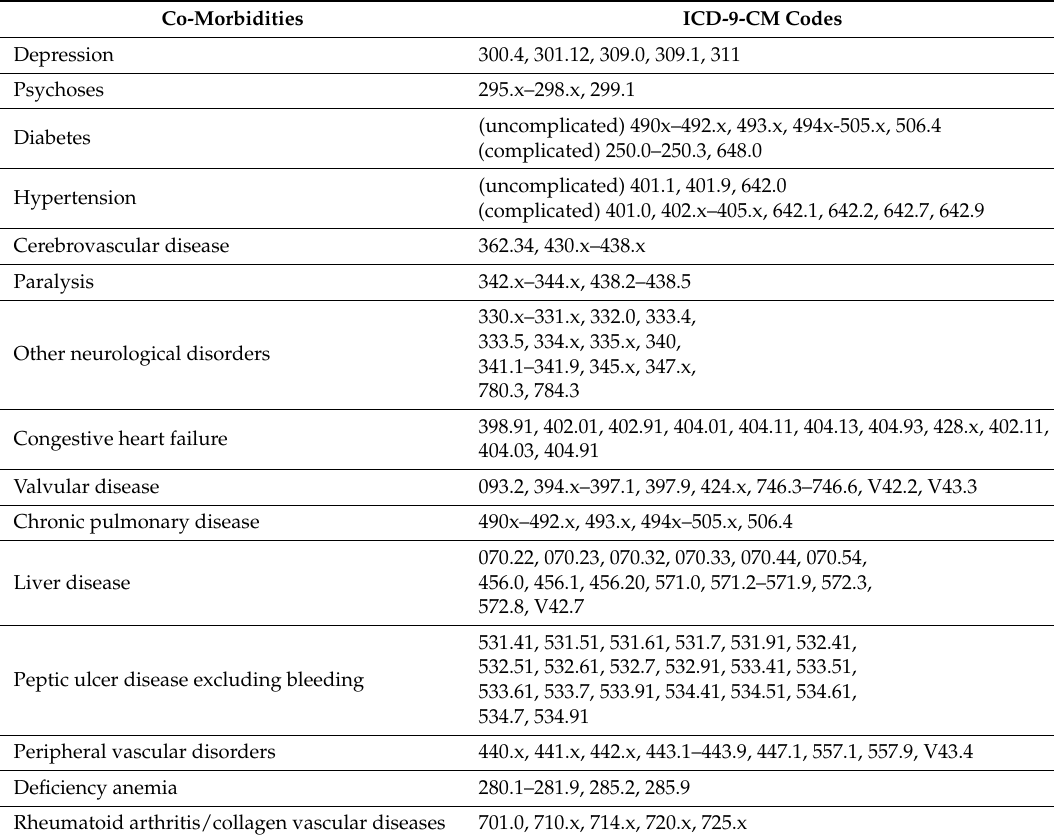
Table A1. ICD-9-CM Coding Algorithms for